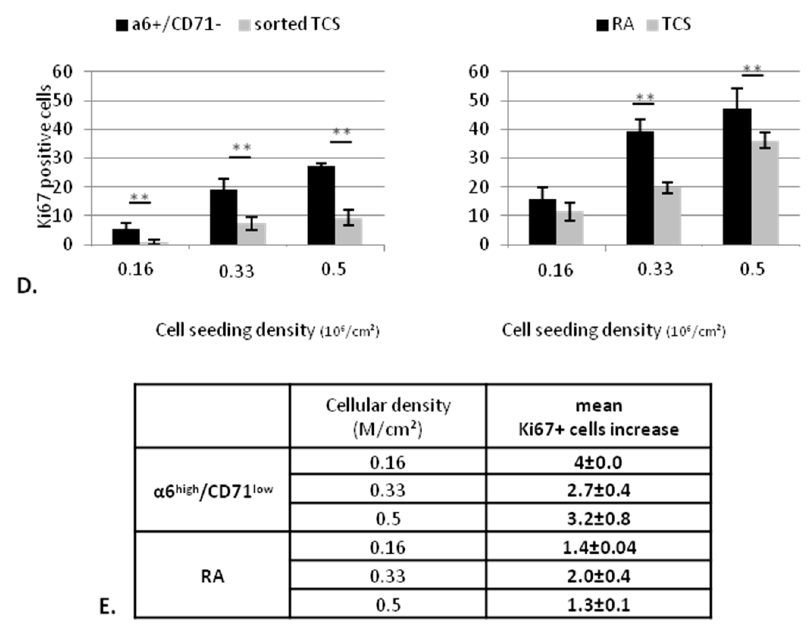
Figure 8. Influence of stem cell isolation method (flow cytometry compared to optimized rapid adhesion method) on capacity of cells to reconstruct human epidermis (RHE). RHE cultured with α 6 high /CD71 low cells and RA are compared to those cultured with corresponding sorted TCS and TCS, respectively) for morphology using hematoxylin-Phloxin-Safran staining ( A ), thickness in µM measured using ImageJ (Research Service Branch, US National Institute of Health, Bethesda, MD, USA) ( B ), and Ki67 labeling ( C ) quantified for Ki67+ cells number in whole tissue length ( D ). Representative results of two donors ( E ) Ki67+ cell number increase for both stem cell candidates ( α 6 high /CD71 low cells and RA) compared to corresponding non-isolated cells, which are equal to 1. * data significantly different ( p < 0.05), ** p < 0.005.